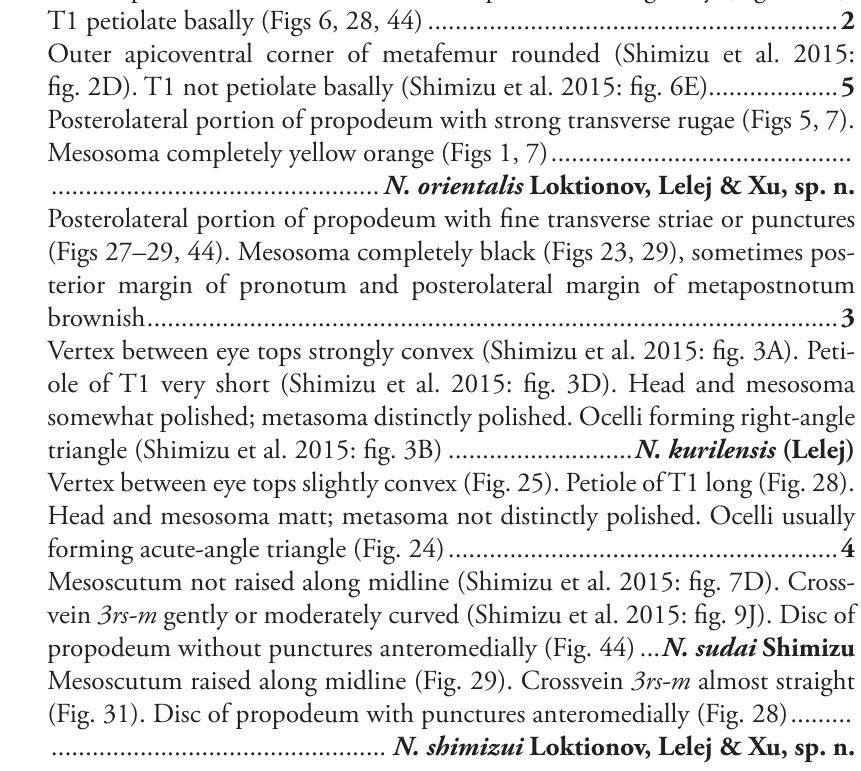
1 Outer apicoventral corner of metafemur produced triangularly (Figs 8, 30). T1 petiolate basally (Figs 6, 28, 44) ............................................................ 2 – Outer apicoventral corner of metafemur rounded (Shimizu et al. 2015: fig. 2D). T1 not petiolate basally (Shimizu et al. 2015: fig. 6E)................... 5 2 Posterolateral portion of propodeum with strong transverse rugae (Figs 5, 7). Mesosoma completely yellow orange (Figs 1, 7) ............................................ ................................................ N. orientalis Loktionov, Lelej & Xu, sp. n. – Posterolateral portion of propodeum with fine transverse striae or punctures (Figs 27–29, 44). Mesosoma completely black (Figs 23, 29), sometimes pos- terior margin of pronotum and posterolateral margin of metapostnotum brownish ..................................................................................................... 3 3 Vertex between eye tops strongly convex (Shimizu et al. 2015: fig. 3A). Peti- ole of T1 very short (Shimizu et al. 2015: fig. 3D). Head and mesosoma somewhat polished; metasoma distinctly polished. Ocelli forming right-angle triangle (Shimizu et al. 2015: fig. 3B) ........................... N. kurilensis (Lelej) – Vertex between eye tops slightly convex (Fig. 25). Petiole of T1 long (Fig. 28). Head and mesosoma matt; metasoma not distinctly polished. Ocelli usually forming acute-angle triangle (Fig. 24) ......................................................... 4 4 Mesoscutum not raised along midline (Shimizu et al. 2015: fig. 7D). Cross- vein 3rs-m gently or moderately curved (Shimizu et al. 2015: fig. 9J). Disc of propodeum without punctures anteromedially (Fig. 44) ... N. sudai Shimizu – Mesoscutum raised along midline (Fig. 29). Crossvein 3rs-m almost straight (Fig. 31). Disc of propodeum with punctures anteromedially (Fig. 28) ......... ................................................. N. shimizui Loktionov, Lelej & Xu, sp.